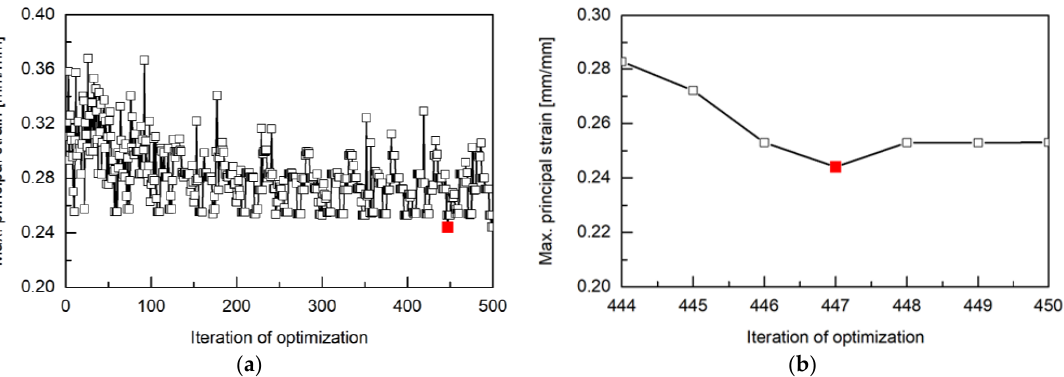
Figure 13. Optimization histories using MIGA: ( a ) optimization history; ( b ) detailed view of opti- mization history.